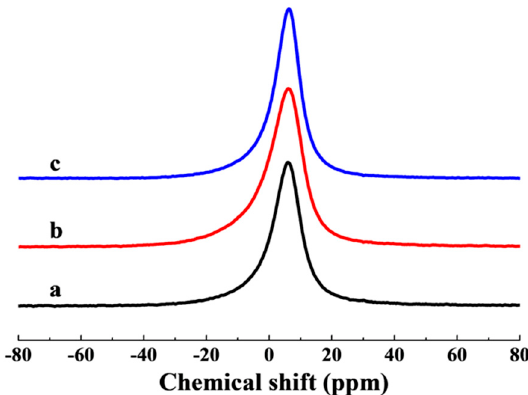
Figure 4. 27 Al NMR spectra of the solid products after lithium recovery from LiAl-LDHs at varied initial Li + concentrations ( a ) 6.75 g / L, ( b ) 3.375 g / L, ( c ) 1.6875 g / L.